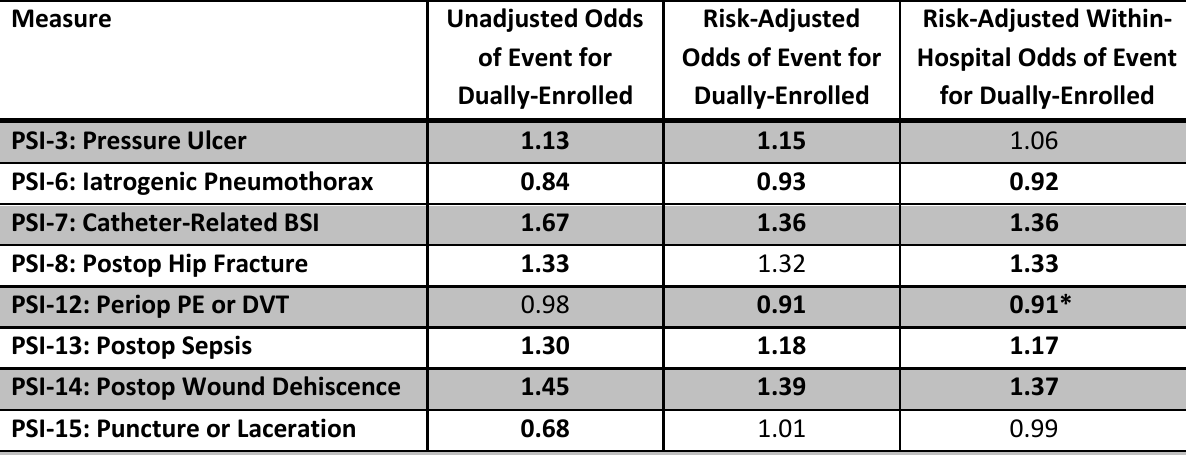
Table 6.5: Social Risk and PSI Measure Performance, Dually-Enrolled Versus Non-Dually-Enrolled Measure Unadjusted Odds